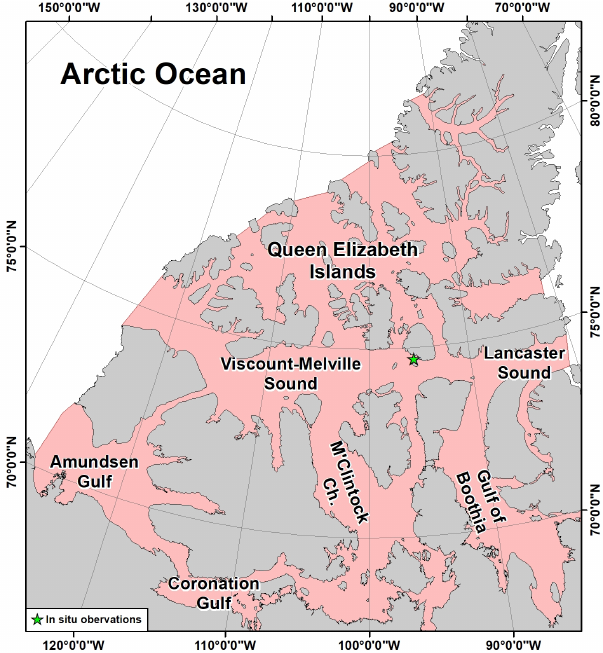
Figure 1. Map of the Canadian Arctic Archipelago region (red shading). The green star indicates the location of the lidar and aerial photograph